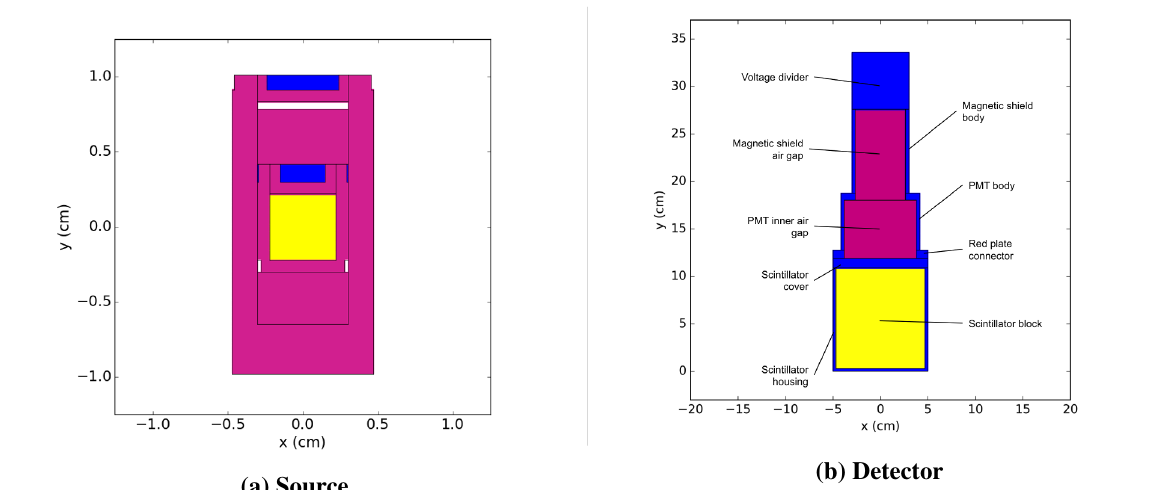
Figure 1: Labelled models of the X1 source capsule and EJ-309 liquid scintillator detectors.